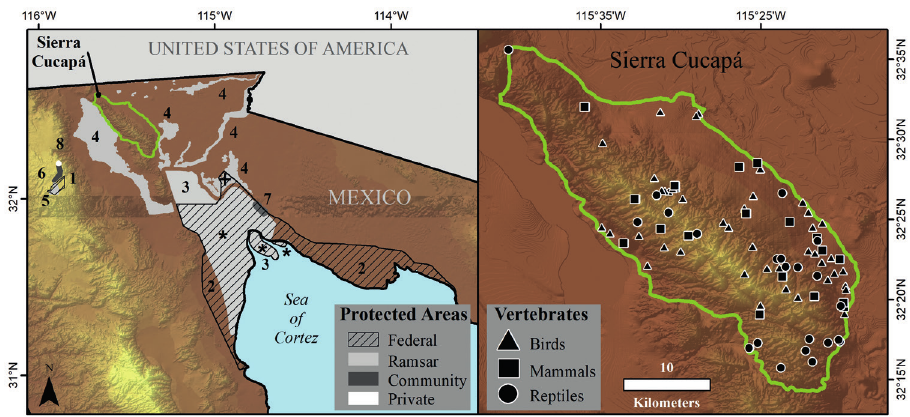
Figure 1. Location of protected natural areas in northern Baja California: government NPAs 1) Parque Nacional Constitucion de 1857, 2) Reserva de la Biosfera Alto Golfo de California y Delta del Río Colo- rado; Ramsar Sites 3) Humedales del Delta del Río Colorado, 4) Sistema de Humedales Remanentes del Río Colorado, 5) Laguna Hanson; Community NPAs 6) Rancho Rodeo del Rey, 7) El Doctor, and Private NPAs 8) Rancho Rodeo del Rey. * indicates the overlap zone between NPAs 2 and 3, + indicates the overlap zone between NPAs 2 and